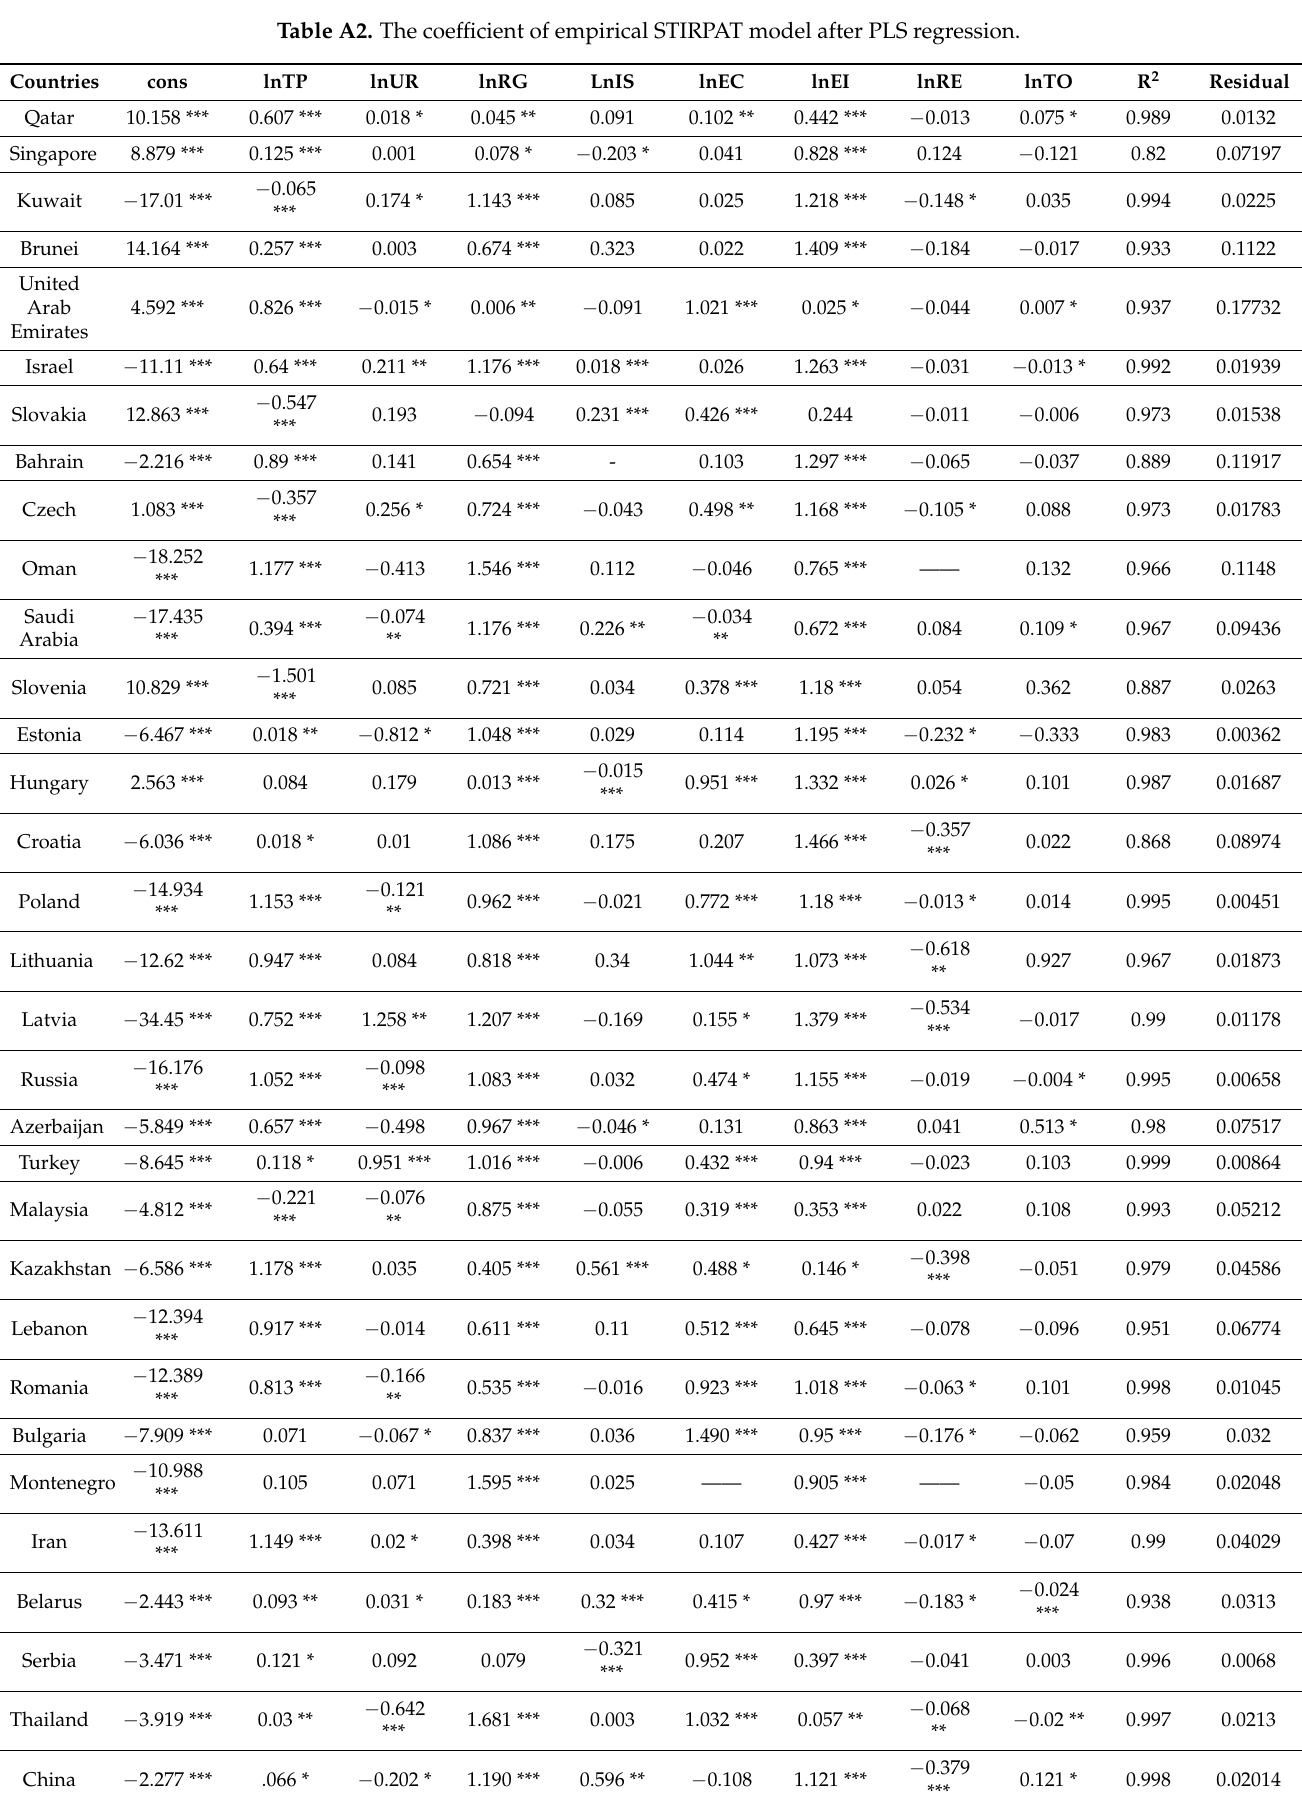
Table A2. The coefficient of empirical STIRPAT model after PLS